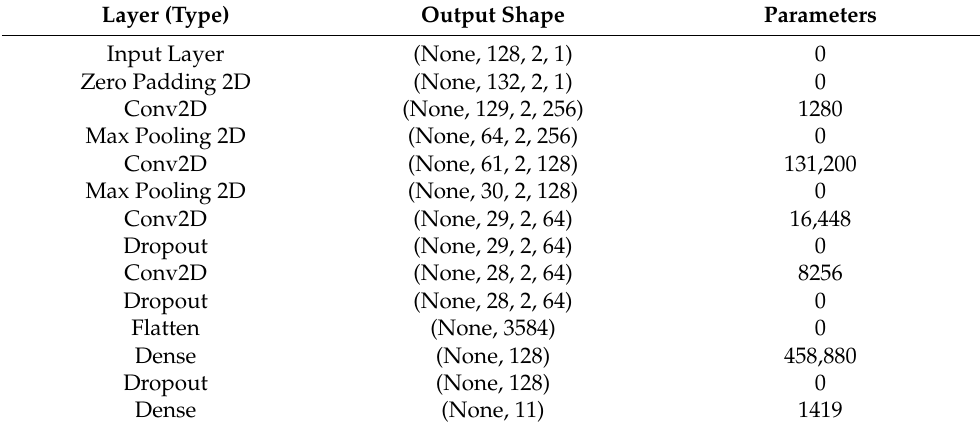
Table 7. Architecture of CNN 2D.